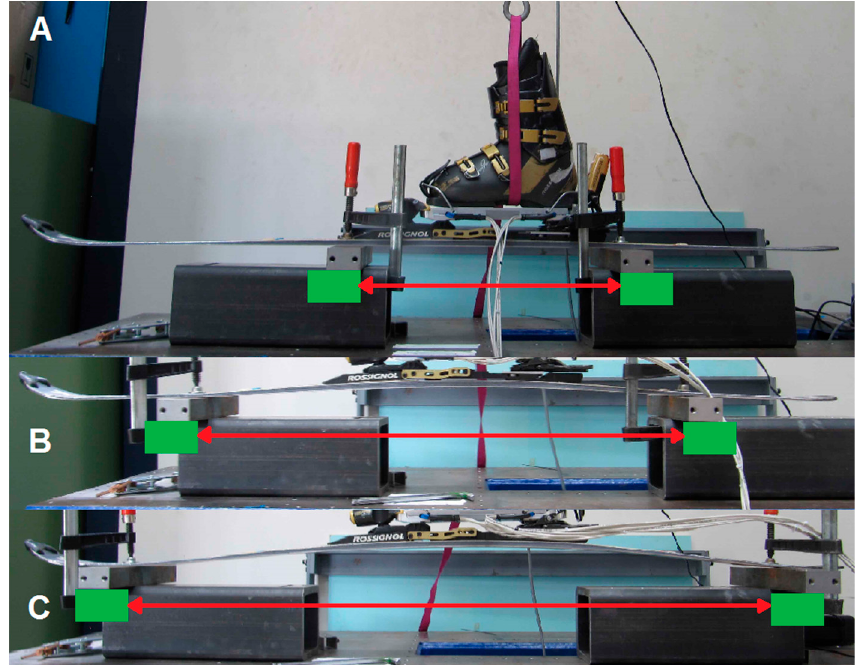
Figure 4. The three different fastening situations for the fifth test condition. The ski could bend between the two fastening elements (in green): ( A ) Distance of 0.5 m. ( B ) 0.9 m. ( C ) 1.3 m. For each test, the coefficient of calibration was defined as the tension measured on the sensor divided by the applied load. Average coefficients